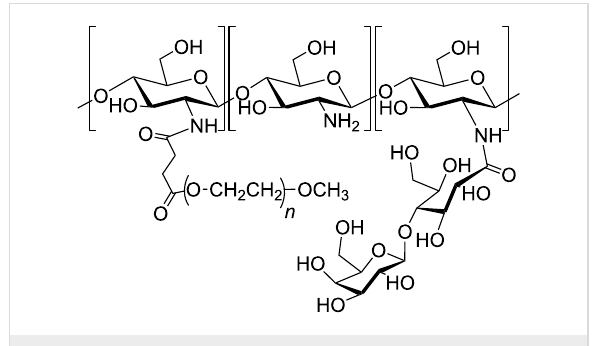
Figure 5: PEGylated chitosan derivative, adapted from [61].